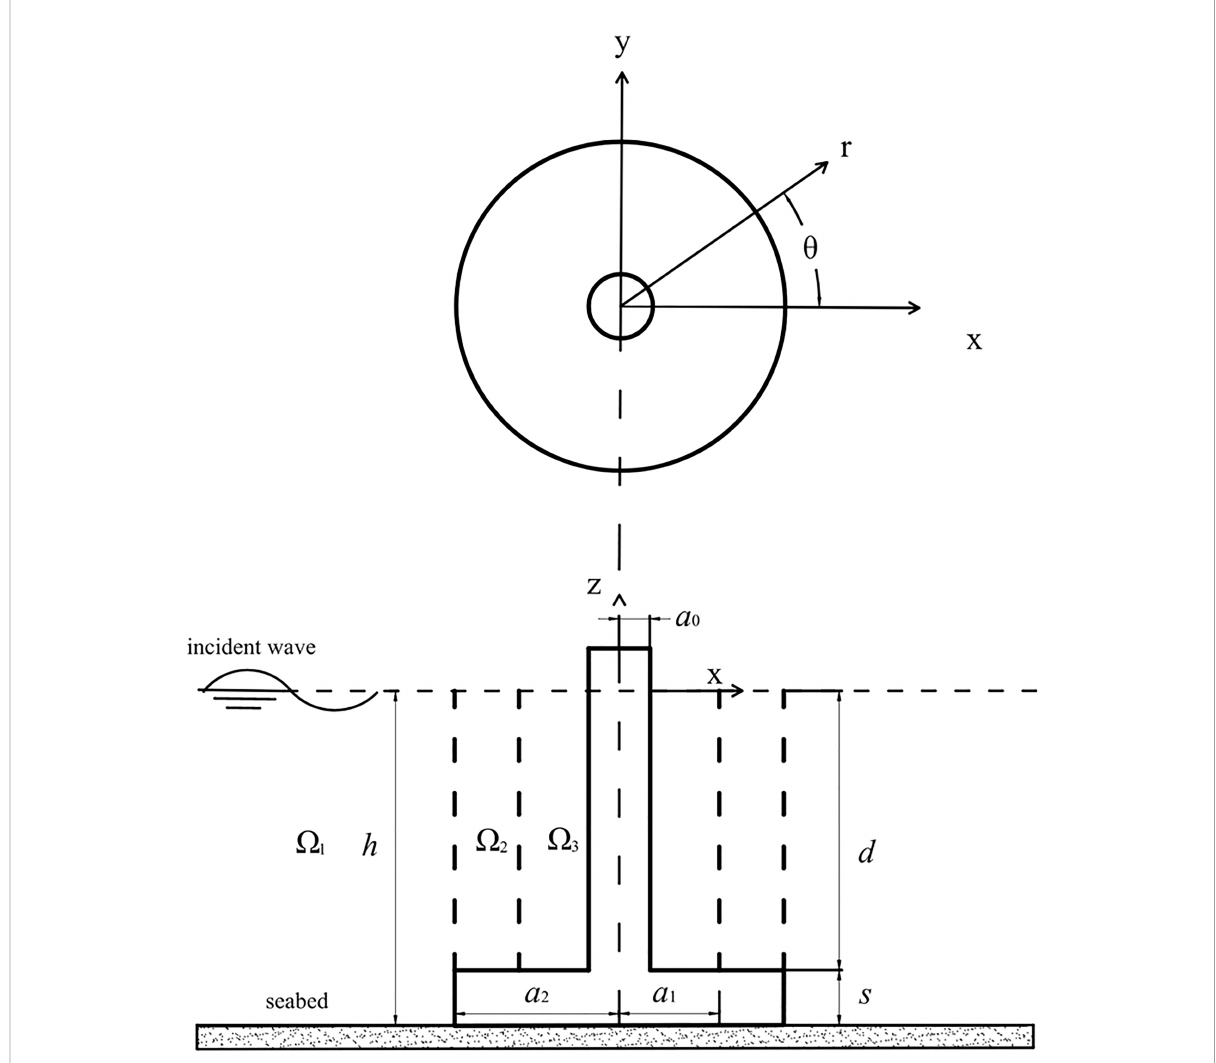
FIGURE 2 Sketch of the hybrid structure and division of the fl uid